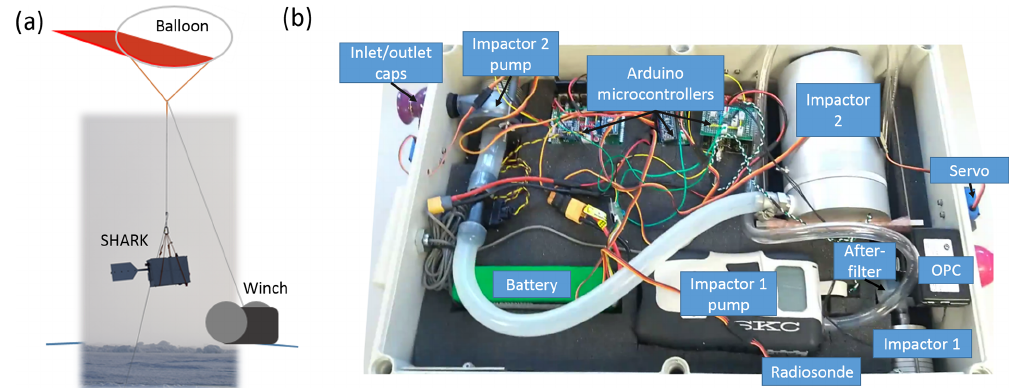
Figure 1. The SHARK. (a) The SHARK payload on a tethered balloon connected to ground by a winch. The photograph was taken during deployment in the High Arctic. (b) The components inside the SHARK payload labelled on a photograph. The payload featured a large impactor inlet at the top of the platform for Impactor 2, with the OPC inlet facing the front, and a small impactor inlet at the bottom for Impactor 1. The radiosonde was at the bottom of the box, and the outlet valve for the pump system is shown at the back of the SHARK, where the 100Lmin − 1 pump for Impactor 2